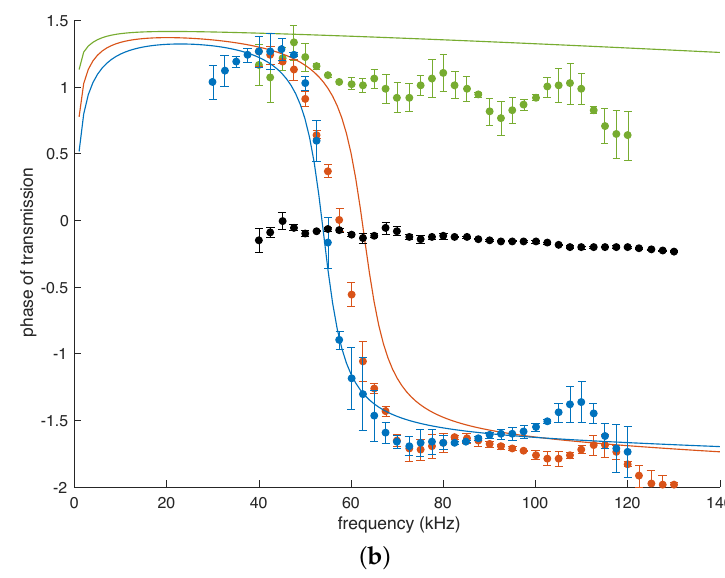
Figure 4. Amplitude ( a ) and phase ( b ) of the acoustic transmission through arrays of air bubbles in a yield-stress fluid (see Table 1 for the geometrical parameters of the samples). Black symbols show the result for the yield-stress fluid alone, without bubbles. Solid lines are the predictions of Equation (7). Table 1. Geometrical parameters of the three samples of Figure 4. Sample 2 ( L / R = 4.5) is the one shown in Figure 3b.